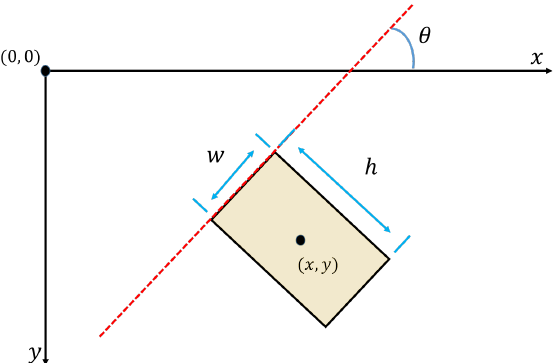
Figure 5. Each rotated bounding box is defined by five parameters: { x , y , w , h , θ } . { x , y } represent the center of the rectangle. θ(cid:101) [ − 90,0 ) denotes the rotation angle of the bounding box. If the x-axis rotates counterclockwise, the first side of the rectangle encountered is w , and the other side is h , so then the rotation angle of the x-axis is θ for rotated bounding box.